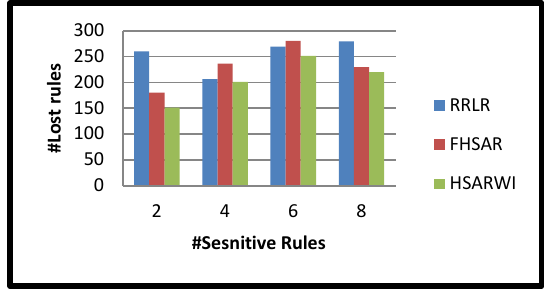
Figure 1. Lost rules in chess with MST = 0.95 and MCT = 0.98.